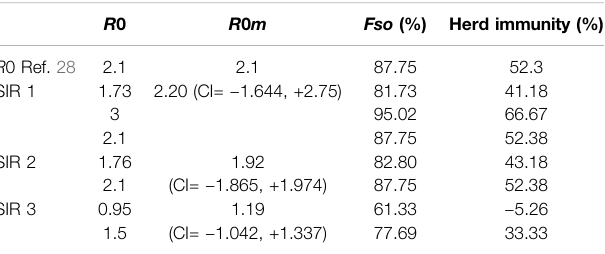
TABLE 1 | R 0 values generated with three SIR models showing the maximum number of people who may be infected (Fso), and herd immunity for each model.